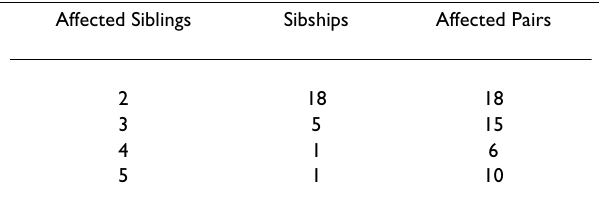
Table 1: Distribution of Affected Sibship Sizes Affected Siblings Sibships